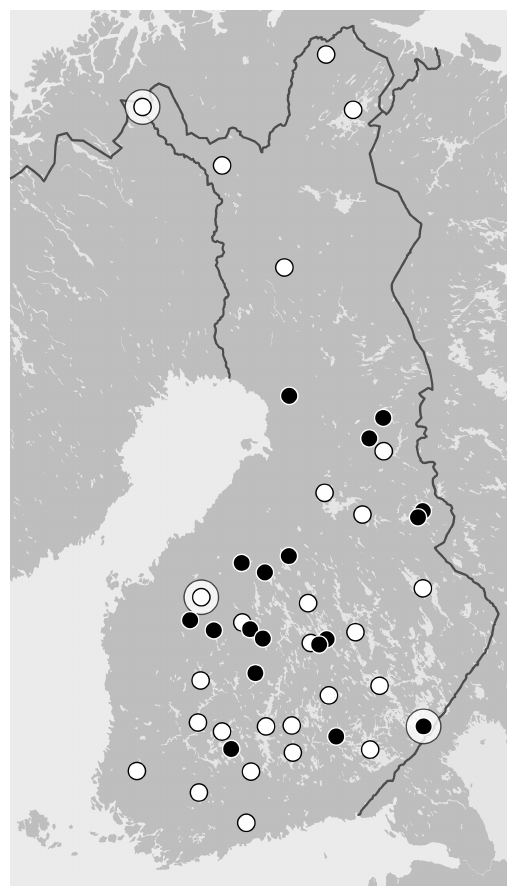
Figure 2. Map of SYKE observation points used in this study: lakes with both lake surface water temperature (LSWT) and lake ice date (LID) observations (white) and lakes where only LID is available (black). On lakes Lappajärvi, Kilpisjärvi and Simpelejärvi also ice thickness and snow depth measurements were used (Sect. 4.3); they are surrounded with a large white circle. The list of lakes with co- ordinates is given in Appendix Table